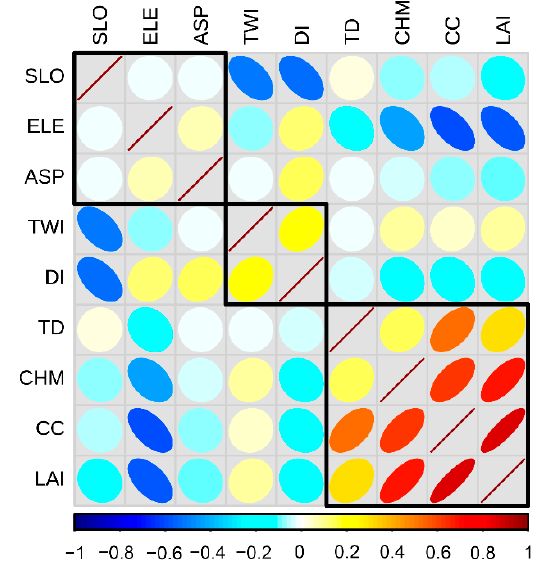
Figure 8. Pearson correlations between topography and forest indexes. Strength and direction of the correlations are denoted by ellipse size and colors (as per scale bar). The size of ellipse in plot cells is proportional to the Pearson correlation coefficients (r). The scale bar extends from perfect negative correlation (dark bule, r = − 1) to perfect positive correlation (dark red, r = 1). Black rectangles categorize the indexes into groups based on the Hierarchical clustering method. In the plot, SLO, ELE and ASP indicate slope, elevation and aspect, respectively.